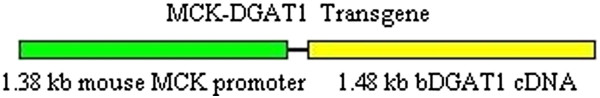
The MCK-DGAT1 transgene. The transgene contains, from the 5′-end to the 3′-end, an 1.38 kb mouse MCK promoter, and an 1.48 kb full-length bovine DGAT1 (bDGAT1) cDNA.